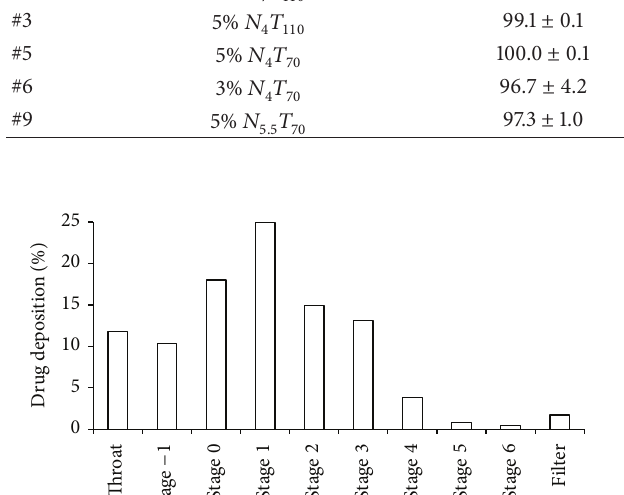
Figure 2: Andersen cascade impactor deposition pattern after the aerosolization of powder (batch #5) sprayed with a 4 𝜇 m nozzle at T 70 ∘ C (#5% N 4 70